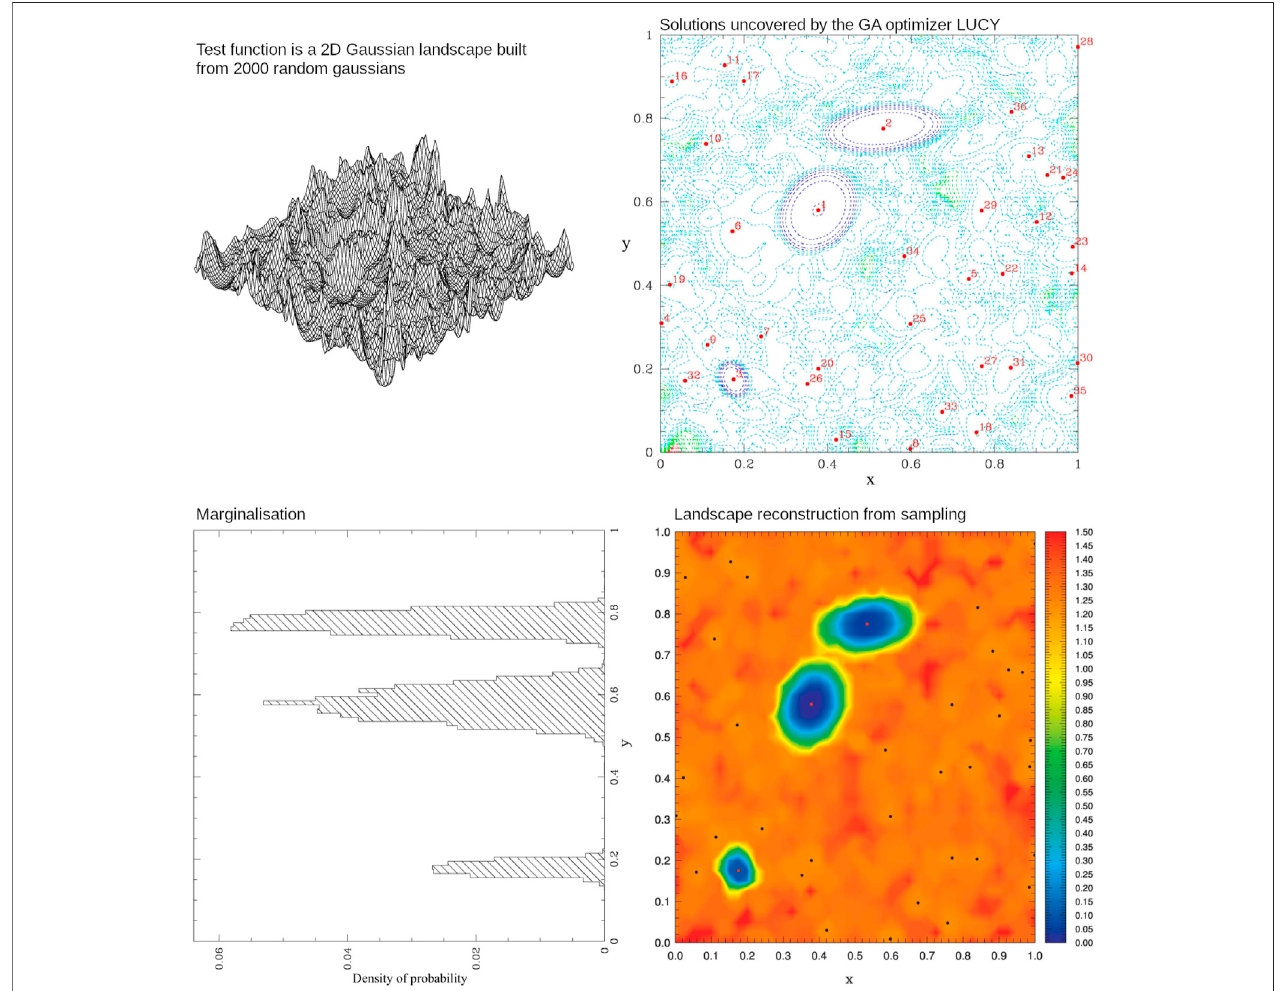
FIGURE 3 | Illustration of the RCGA optimizer (LUCY) capabilities in fi nding the global minimum and most signi fi cant local minima of a complex test function with many localdeeps. The upperleftpanel showsthefunctionconsidered.Ithas3wellde fi ned minima, morevisibleinthecontour map intheupperright panel.All solutions found by LUCY after convergence are indicated by numbered dots (each number giving the rank, by decreasing depth, of the identi fi ed minimum). The lower right panel shows the reconstruction of the test function shape based on the sampling done by the code during the search.